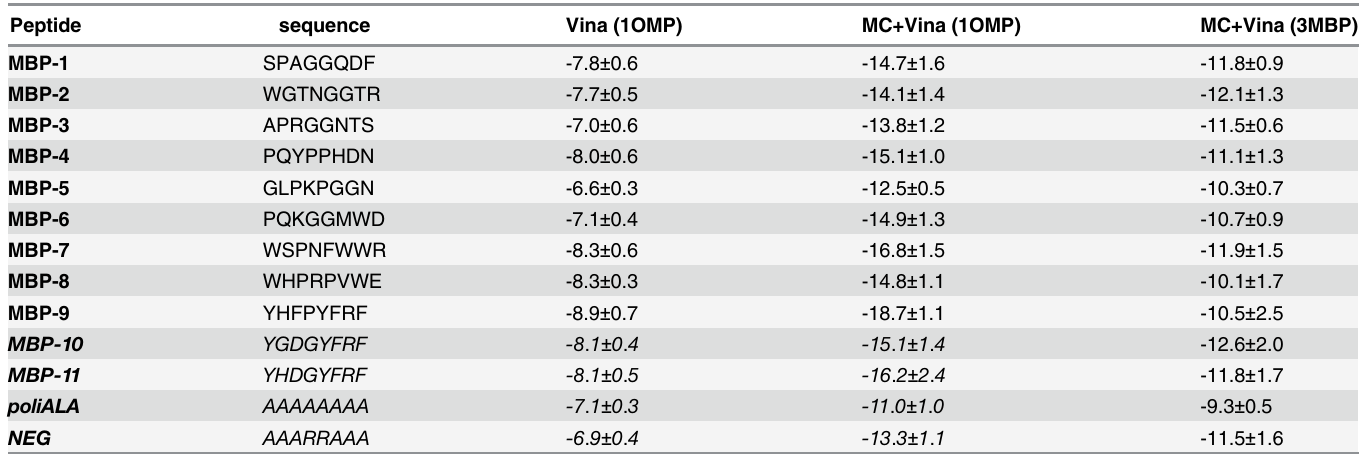
Table 1. Average docking scores. Docking scores are calculated with Autodock Vina over 10 runs each generating 9 configurations, and with MC+Vina over the last 10 configurations of 10 runs. Errors are standard deviations over all the samples. In parentheses the protein configuration used for the docking. All the values are in